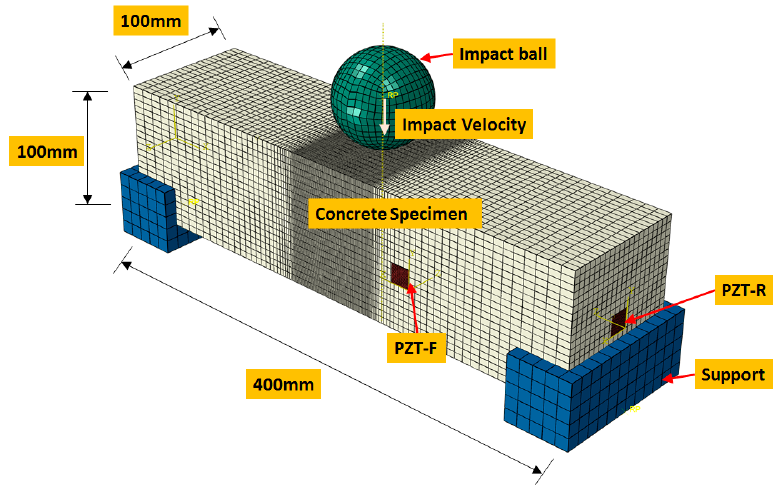
Figure 2. Finite element model of the impact test setup.